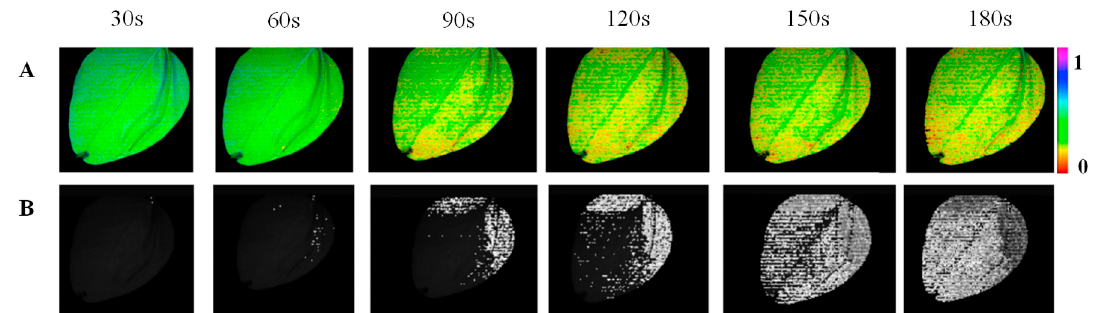
Figure 6. The typical images representing the burn-induced spatio-temporal dynamics of Y (II) in pea leaf: the pseudocolor-coded PAM-images of the same untreated leaf at various time points after the stimulation ( A ), and a binary representation of the CWT results of the initial images ( B ). The pixel becomes white if the reaction reaches the point. The time after the stimulation (burn of the first leaf) is indicated.